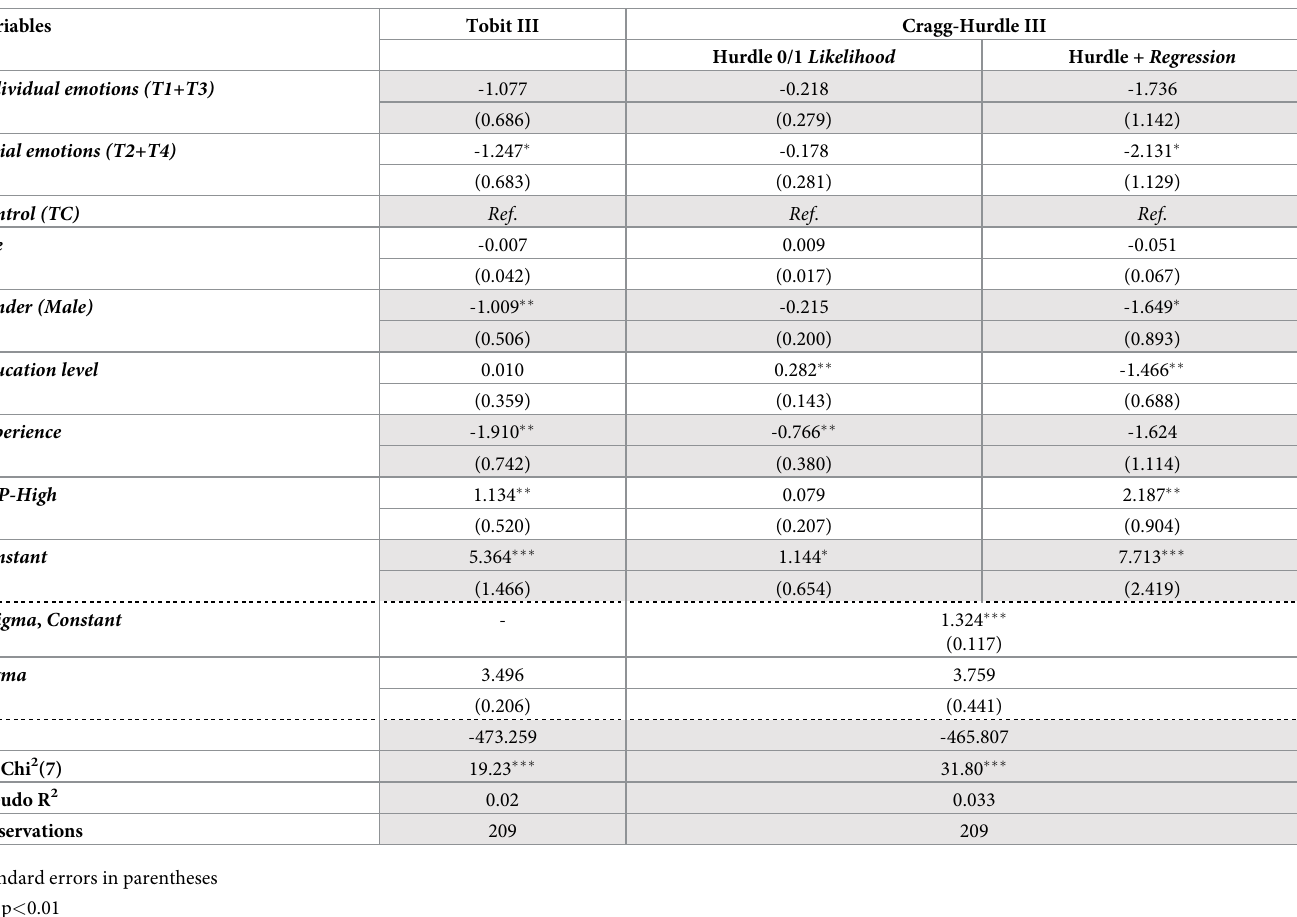
Table 8.2. Treatment effects, intensive and extensive margins of monetary donation/individual and social